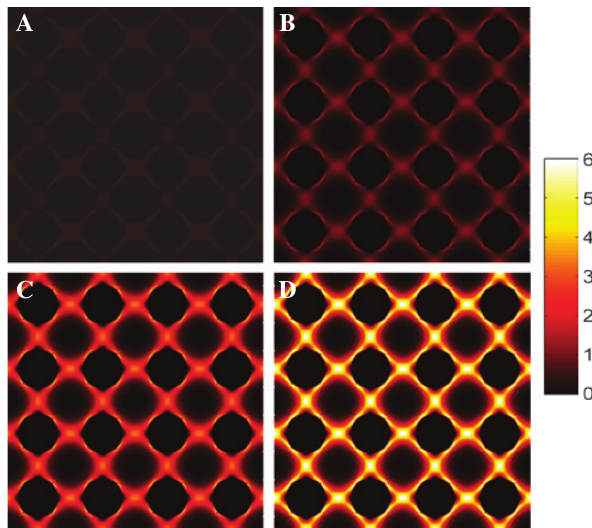
Figure 4: Effective plastic strain fields at macroscopic strains of (A) 0.25%, (B) 0.5%, (C) 1% and (D)